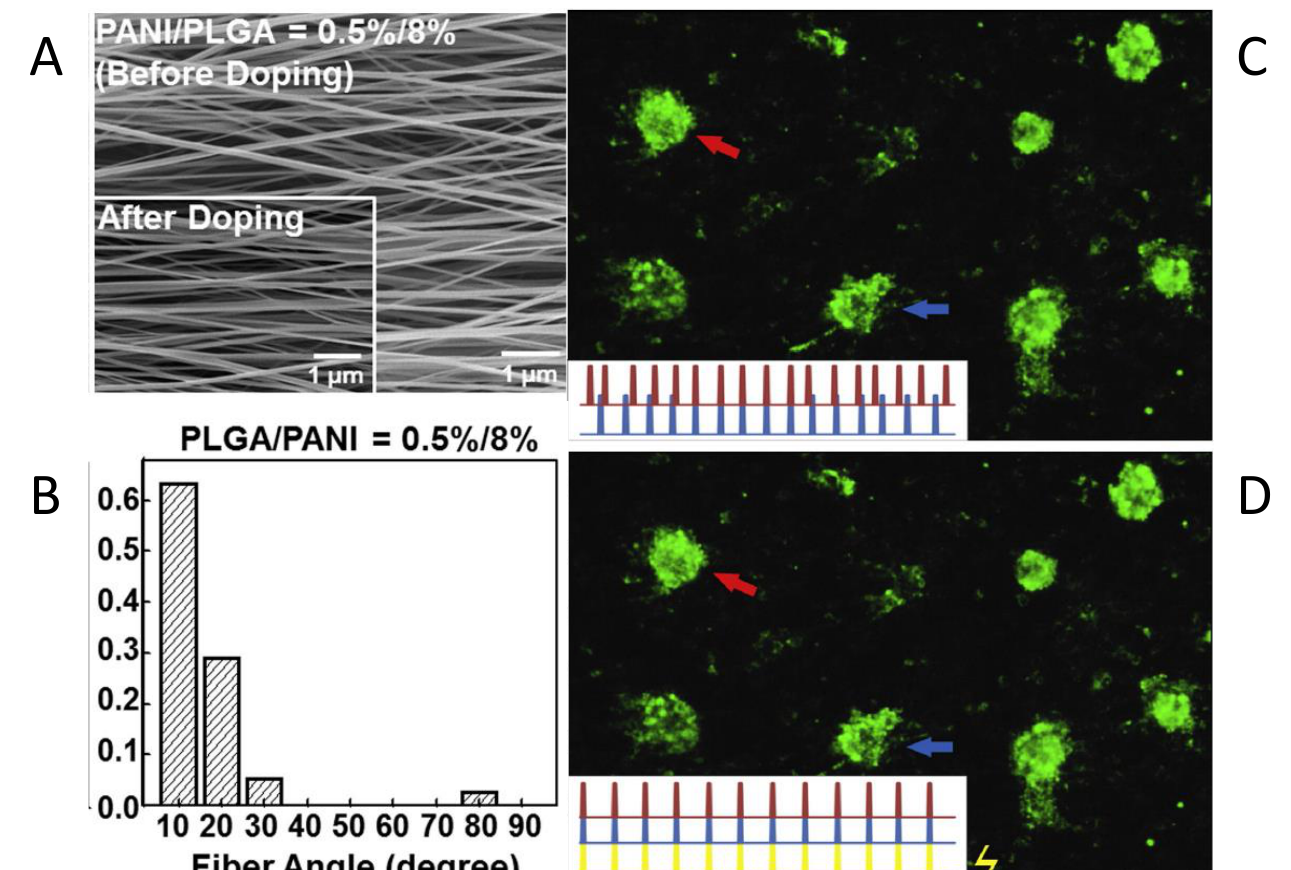
Figure 17. Cardiac tissue scaffold made of a PANI/PLGA blend [208]. ( A ) SEM of PANI/PLGA nanofibers before and after doping with HCl. ( B ) Histogram of fiber angle distribution of PANI/PLGA showing a high degree of alignment. ( C ) Beating frequencies of indicated red and blue cell clusters without electrical stimulation. ( D ) Same beating frequencies as ( C ) but with electrical stimulation applied (yellow) showing synchronization of beating between electrical stimulation and beating in the red and blue cell clusters. Reprinted with permission from Ref. [208]. Copyright 2013, with permission from Elsevier.